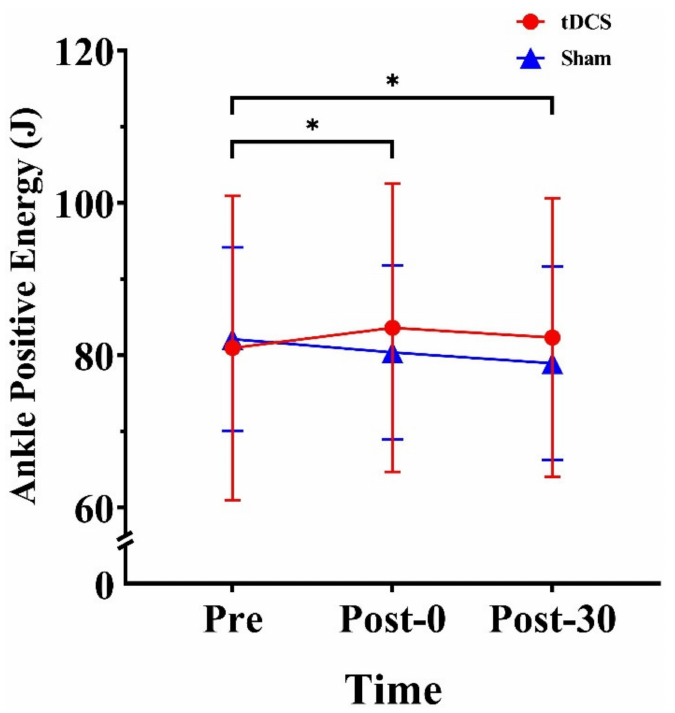
Figure 4. Effects of tDCS on ankle positive energy in CMJs. * indicates a significant difference between times. Pre: pre-stimulation, Post-0: post-0 min, Post-30: post-30 min. The analysis revealed a significant time × stimulation-type interaction effect for ankle = 0.30). Further, the within-group analysis net energy (F (1.32, 18.51) =5.60, p = 0.019, η 2 p = revealed significant differences in the sham condition (F (2, 28) = 7.79, p = 0.002, η 2 p